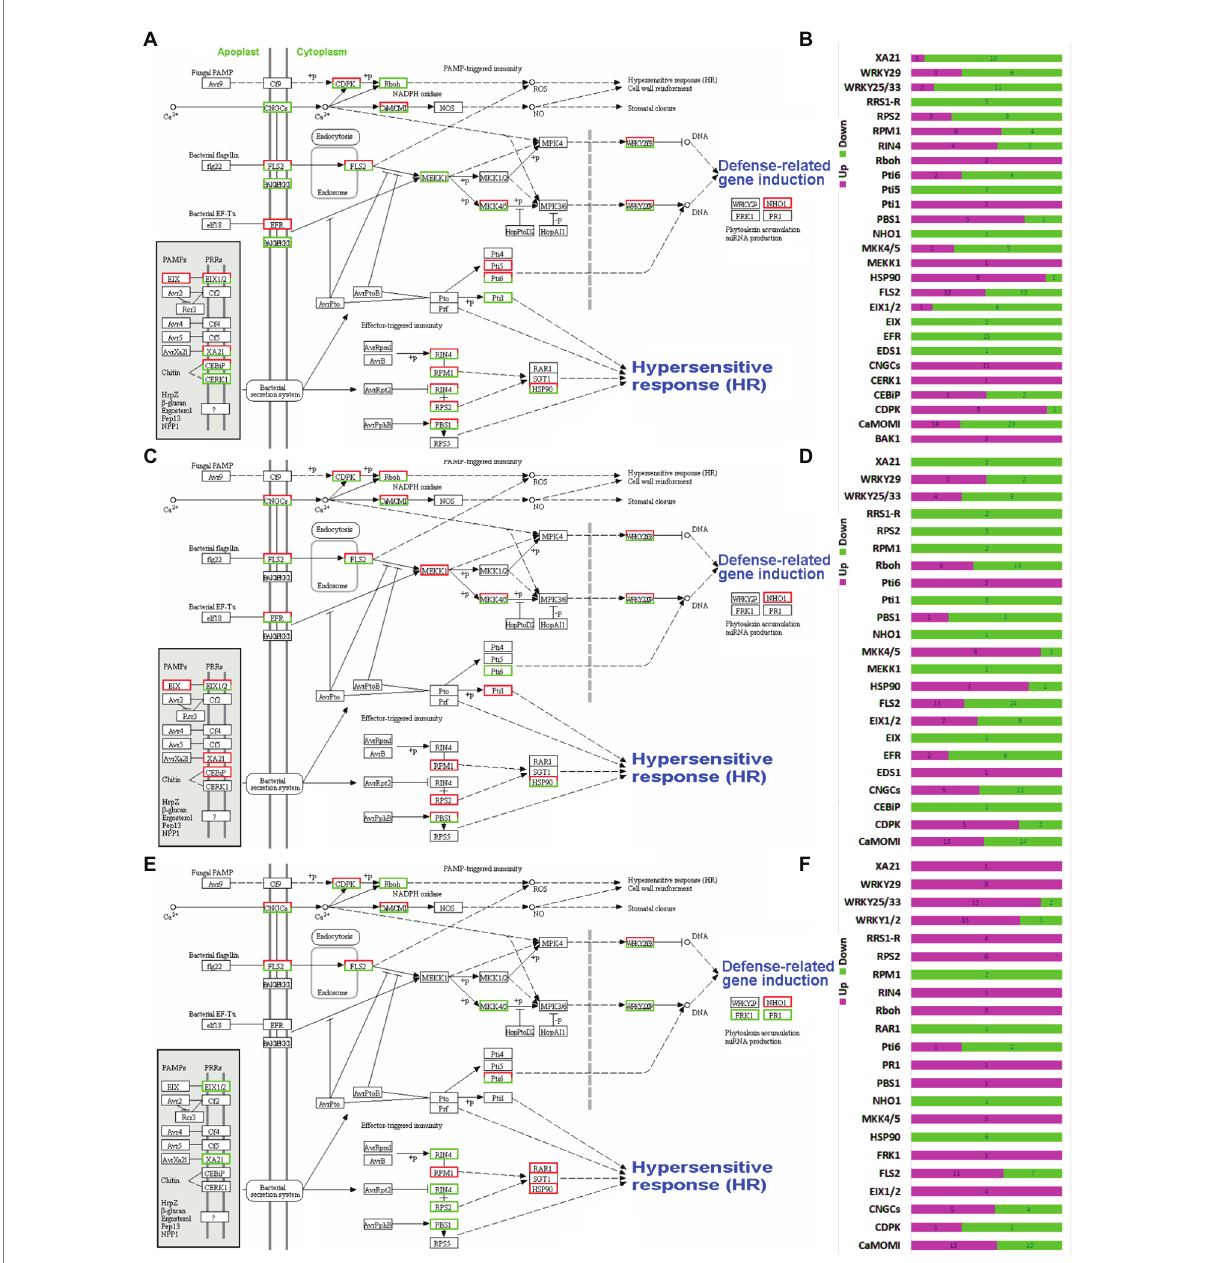
FIGURE 5 Overview of defense response pathway and the distribution of up- and downregulated pathway integrators for C. ensifolium (A,B) , C. goeringii (C,D) , and C. sinense (E,F) .